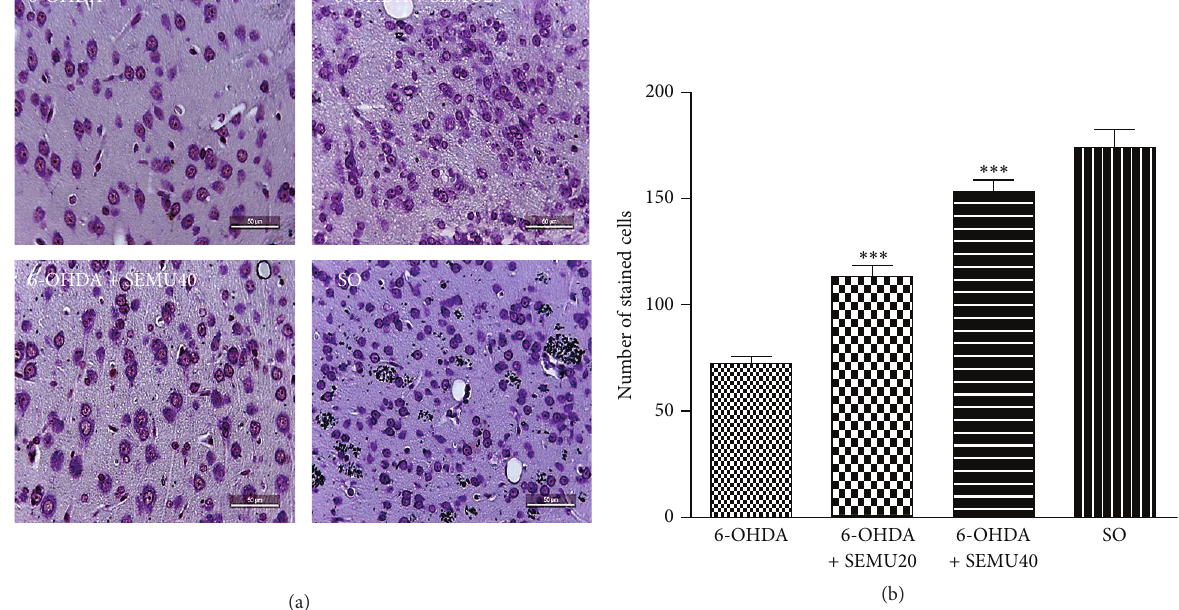
Figure 4: Photomicrographs of cresyl violet staining of the striatal tissue (lesioned right side) from untreated 6-OHDA and SEMU (20 and 40 mg/kg, p.o.) treated groups. The Sham-operated (SO) rats are the control group (a). A lower number of stained cells (indicating neuronal damage and nonviable neurons) are observed in the untreated 6-OHDA group, as related to the 6-OHDA groups treated with SEMU and mainly to the SO group (magnification: 400x). (b) shows the means ± SEM of the number of cells (three different fields), in each group. ∗∗∗ versus untreated 6-OHDA group ( F = 59.85, 𝑃 < 0.0001 ).